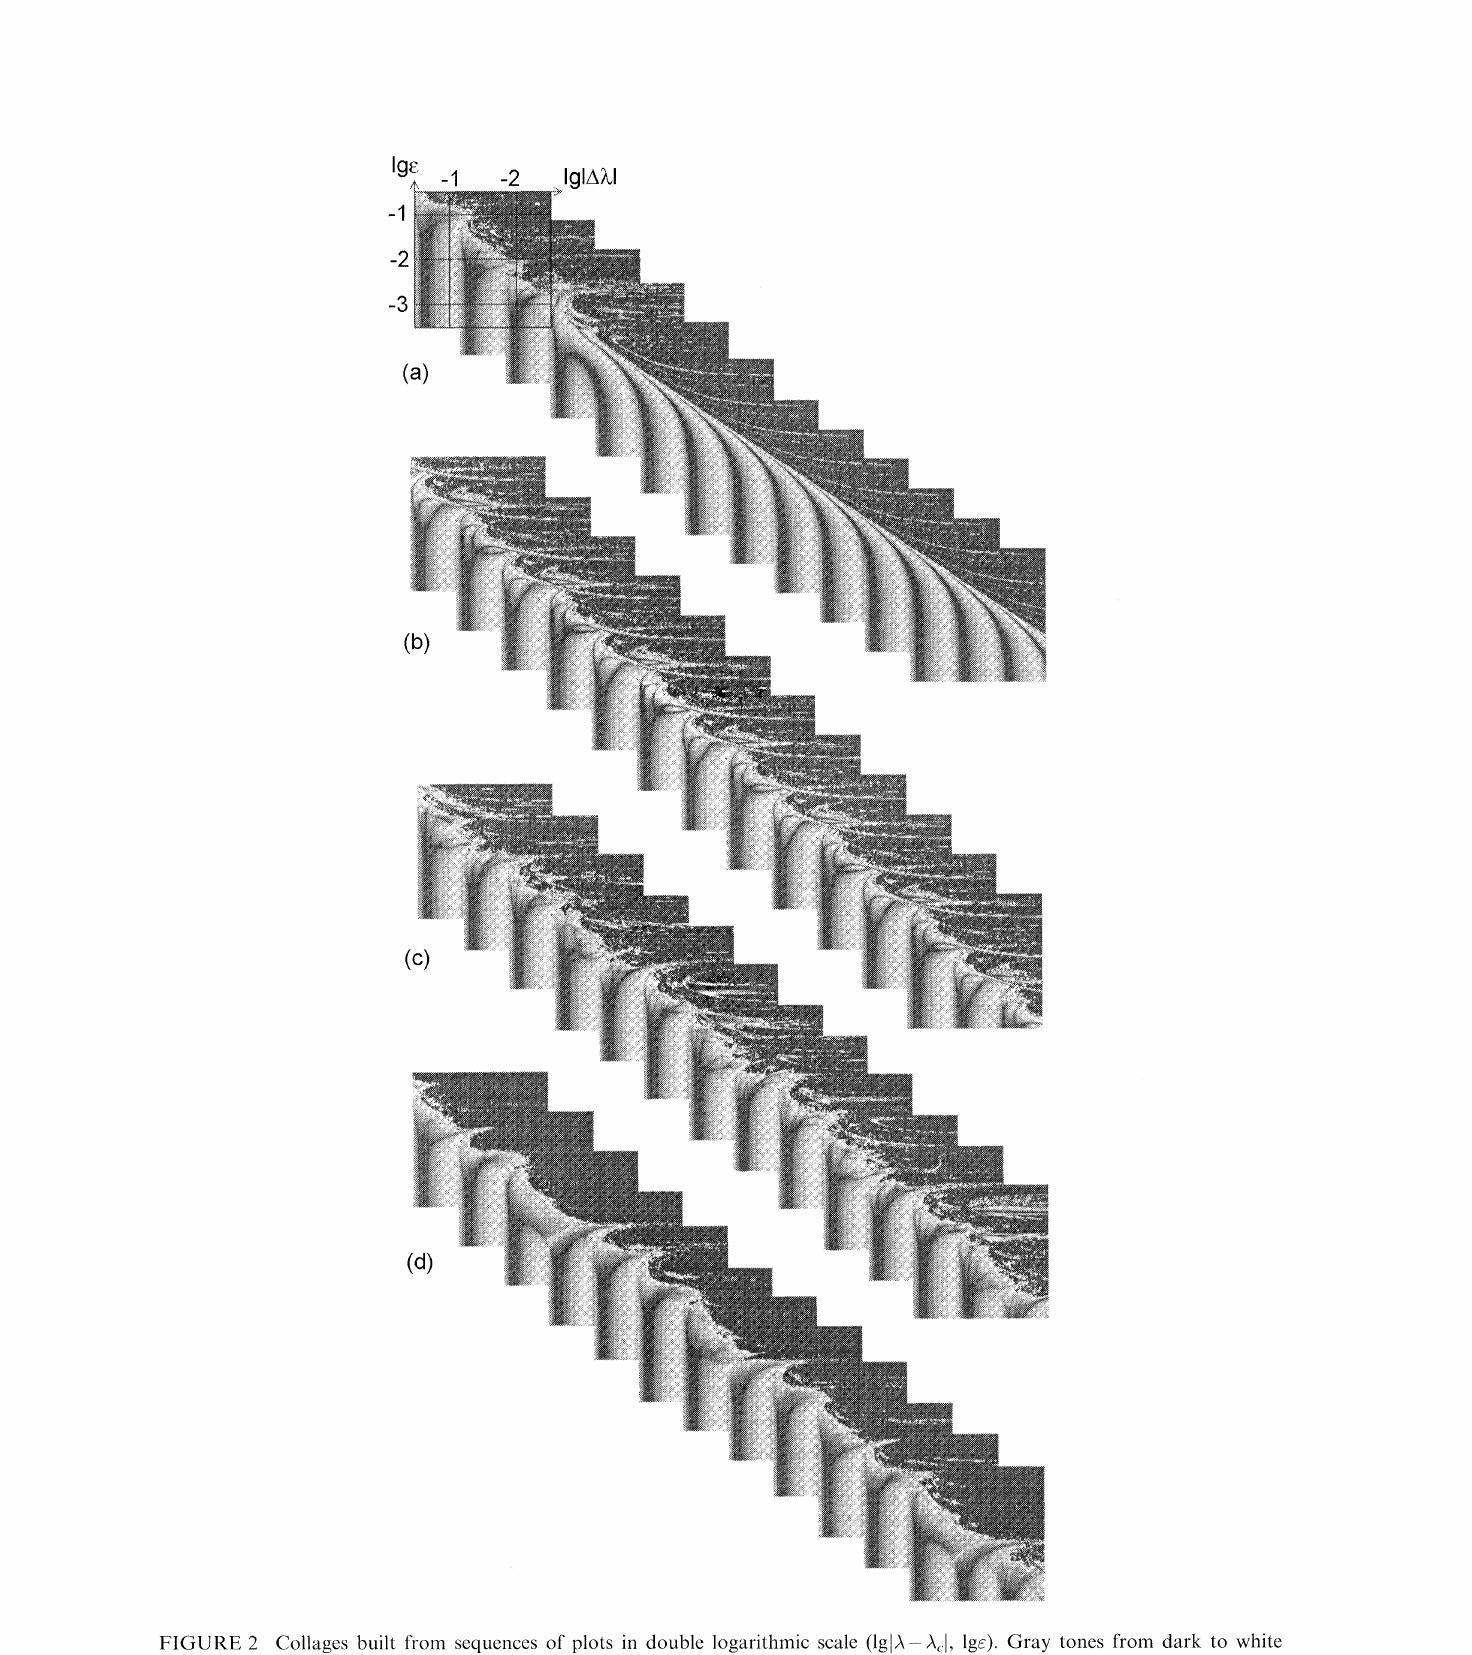
FIGURE 2 Collages built from sequences of plots in double logarithmic scale (lgl,-,,l, lgc). Gray tones from dark to white v, designate values of the rescaled Lyapunov exponent A/Ik- k,,I T 0.4498, from minus infinity to zero, black designates positive A (chaos). Observe the simple self-similarity of the picture at small scales in the case of F-scaling, w 1/8 (a), periodic repetition of the forms- P-scaling, w=1/3 (b), quasiperiodic evolution of the forms Q-scaling, w= 1/7 (c), and chaotic evolution for randomly chosen w (see (18)) S-scaling